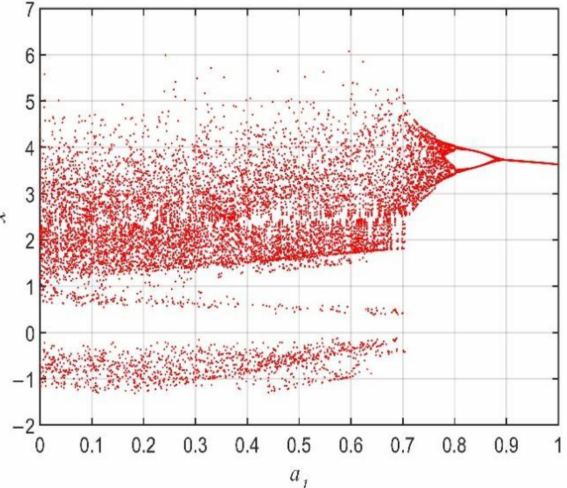
Figure 1. Bifurcation diagram of system (14) with a 1 varying from 0 to 1 for q =